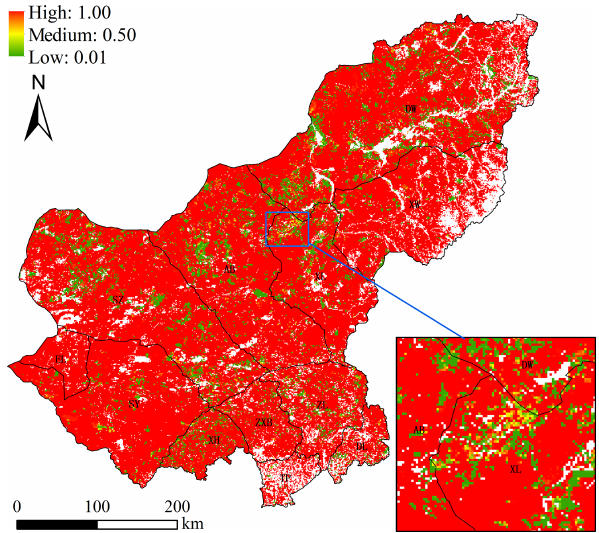
Figure 9. Degradation probability map for grassland in Xilingol, in- cluding a zoom into Xilinhot (XL) for more details. The probability is based on the four most important